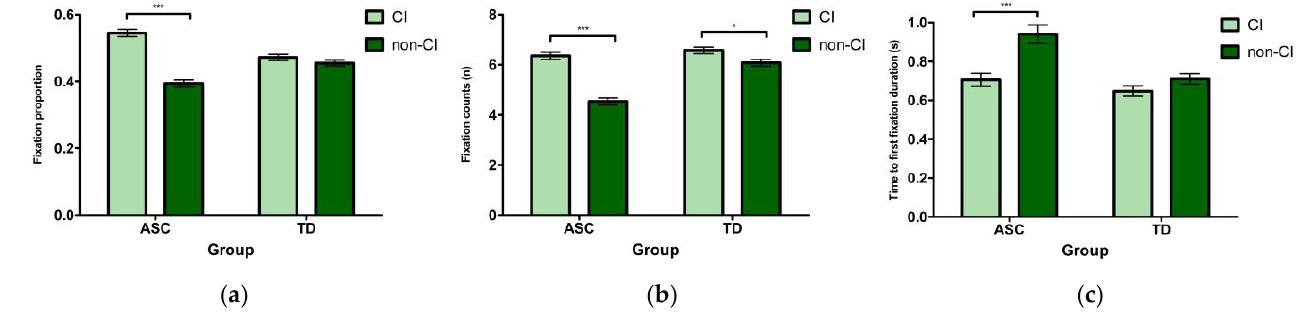
Figure 2. Analysis results related to three eye movement measures for both groups in Experiment 1. ( a ) Preference, ( b ) Detail Orientation, ( c ) Prioritization. Error bars represent standard errors. * p < 0.05, *** p <